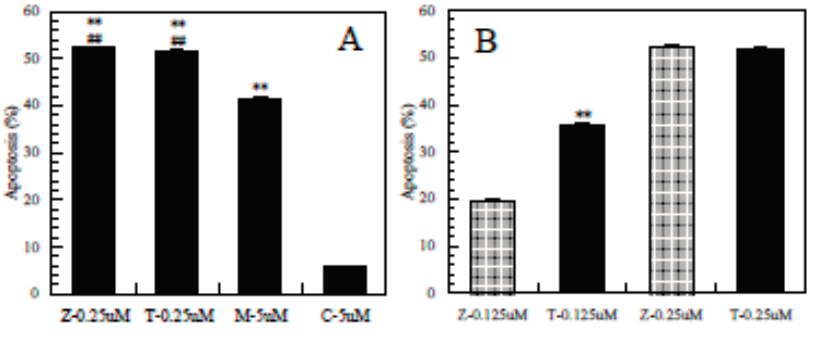
Figure 4. Difference in the ability to induce apoptosis among the pesticides. Z-0.25µM = ziram at 0.25µM, Z-0.125 µM = ziram at 0.125 µM; T-0.25µM = thiram at 0.25µM, T-0.125 µM = thiram at 0.125 µM; M-5µM = meneb at 5 µM; C-5µM = carbaryl at 5 µM, **: p < 0.01, significantly different from 5 µM of carbaryl, ##: p < 0.01, significantly different from 5 µM of maneb ( A ), **: p < 0.01 significantly different from 0.125 µM of ziram ( B ) by